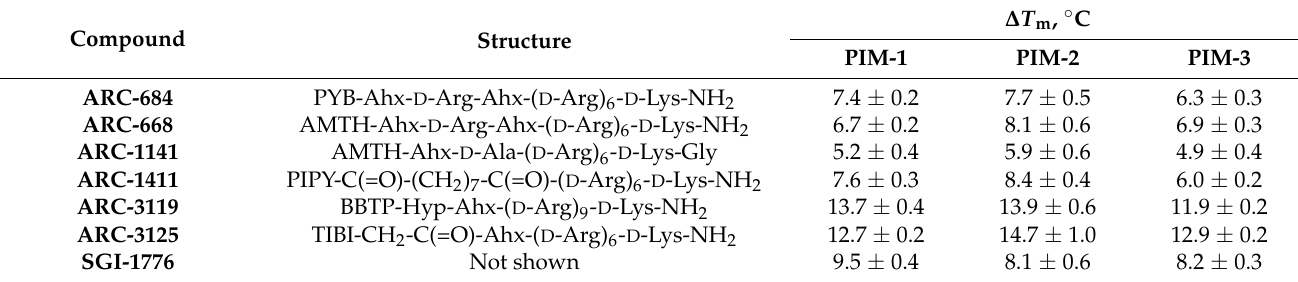
Table 1. Values of thermal shift of screened compounds in complex with PIM kinases.